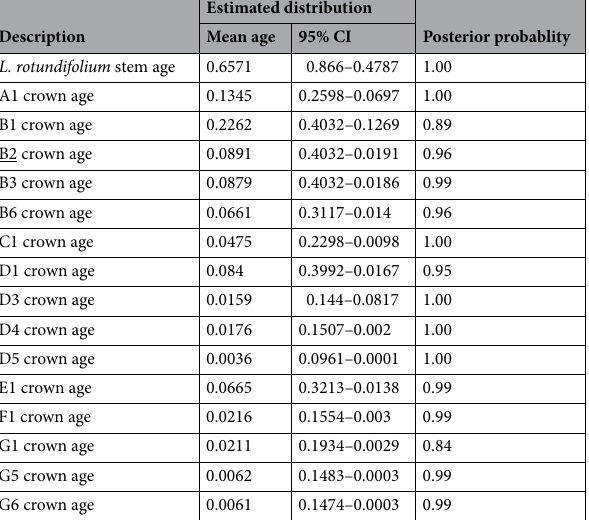
Table 3. Divergence times of haplotypes obtained from the analysis of the phylogenetic tree constructed with three intergenic spacer regions in cpDNA ( psb A -trn H, ndh C ret-trn V - comp, and trn T(GGU) - comp -psb D - comp). Numbers are in million